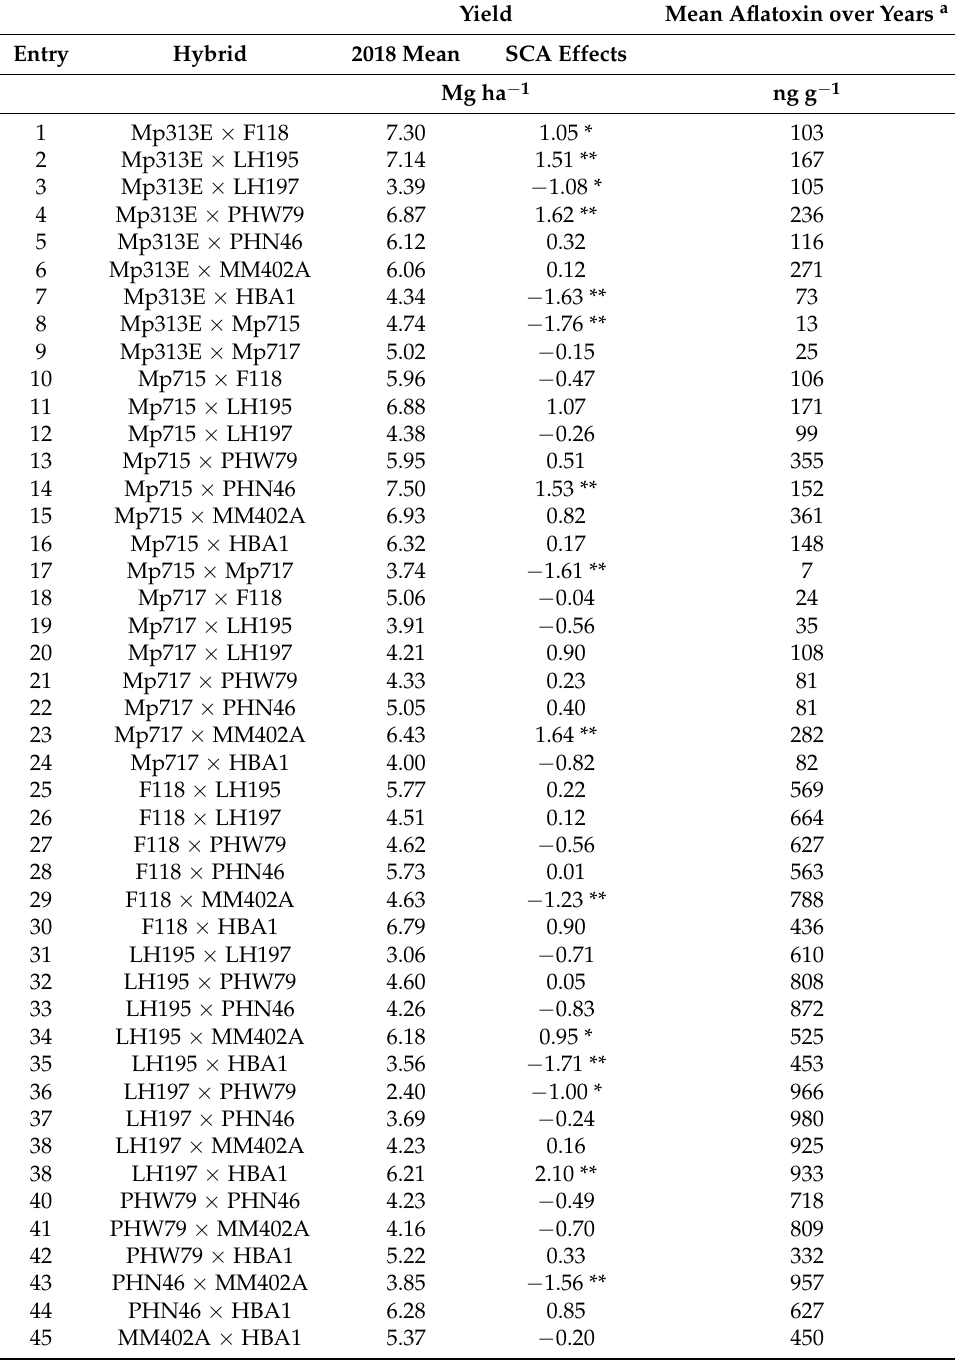
Table 7. Mean yield and estimates of specific combining ability (SCA) effects for F 1 hybrids compris- ing a diallel cross grown in 2018 and mean aflatoxin accumulation for the same F 1 hybrids combined over 2018 and